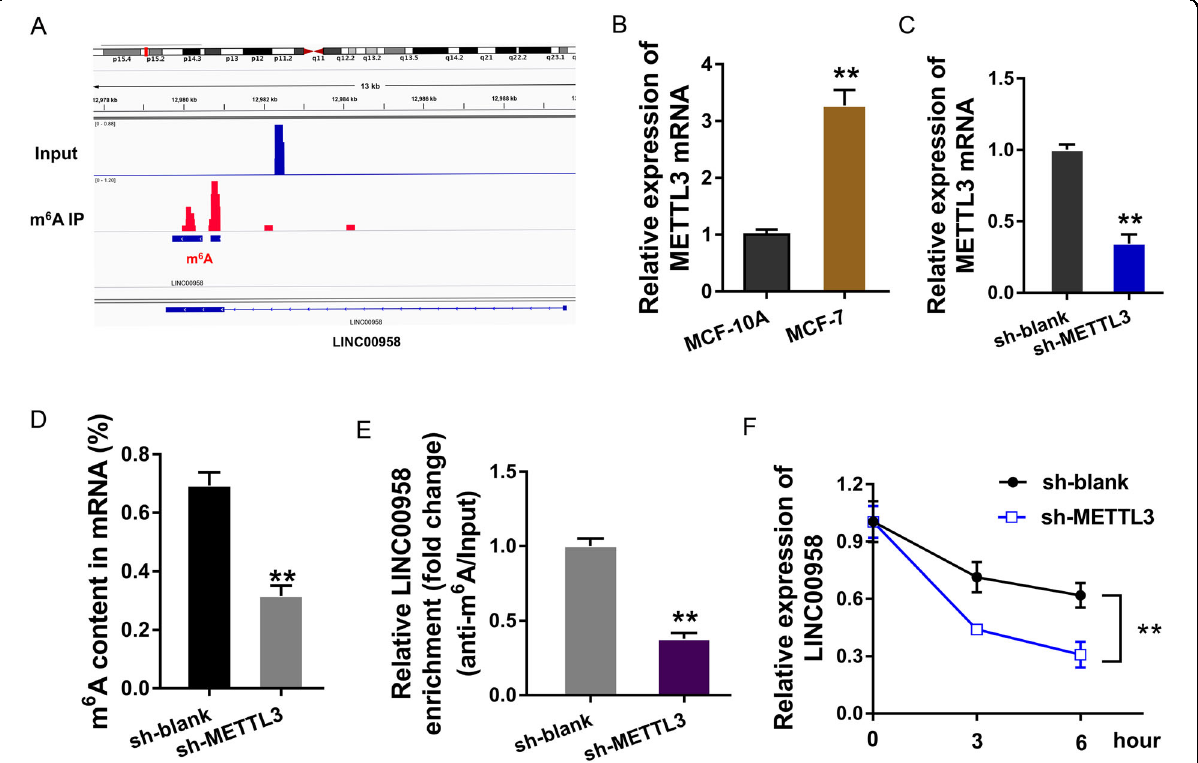
Fig. 2 m 6 A induced the upregulation of LINC00958 in BC cells. A MeRIP-Seq analysis revealed a notable m 6 A modi fi cation site at the LINC00958 location. B RT-PCR indicated upregulated METTL3 mRNA expression in the BC cell line (MCF-7). C METTL3 knockdown (sh-METTL3) was transfected into MCF-7 cells to silence METTL3 expression. D M 6 A analysis (colorimetric method) presented m 6 A modi fi cation enrichment in sh-METTL3 or sh-NC transfection. E MeRIP-qPCR illustrated the m 6 A-modi fi ed LINC00958 level after METTL3 silencing or control. F RNA stability analysis demonstrated the LINC00958 level in MCF-7 cells transfected with METTL3 silencing. ** p < 0.01 was considered as signi fi